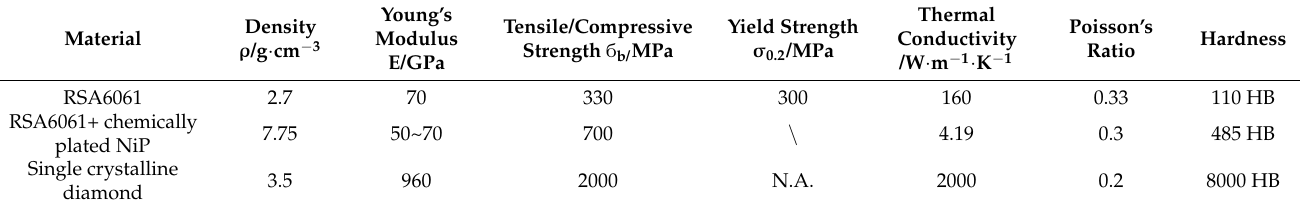
Table 3. Tool and workpiece material